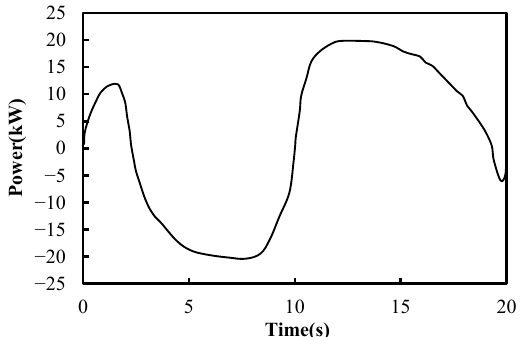
Figure 5. Measured dynamometer card.